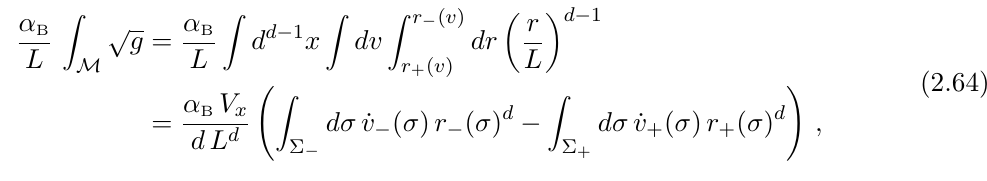
Figure 2 . Left: Sketch of a codimension-zero region where boundaries Σ ± are constant mean curvature slices, determined by the functional in eq. (2.60). Right: Taking the limit α boundaries Σ become null surfaces, and the region becomes the WDW ±